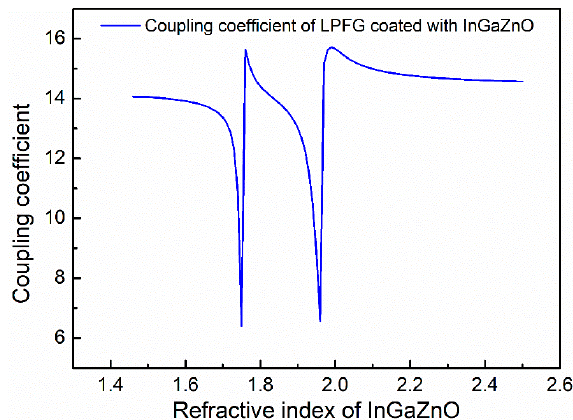
Figure 2. Relationship between coupling coefficient and film refractive index of long-period fiber grating (LPFG).